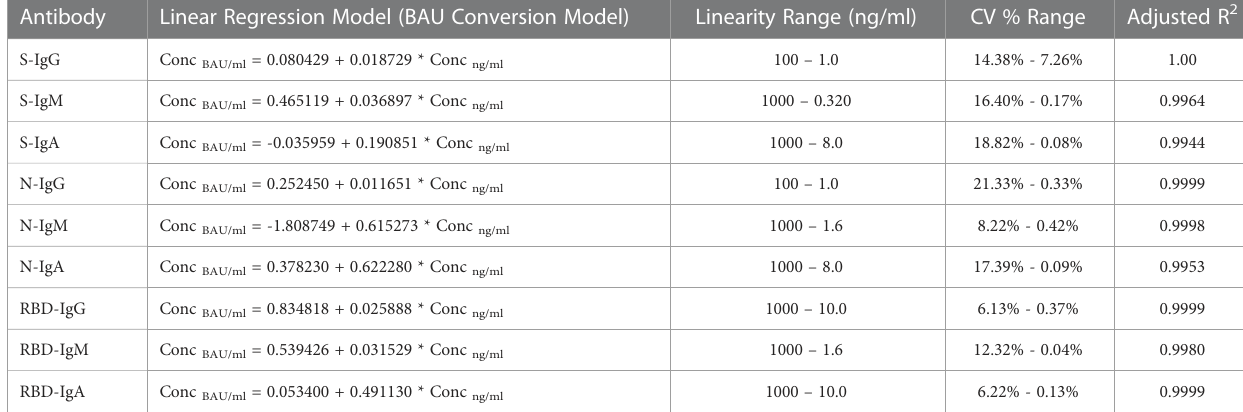
TABLE 6 Table showing the Linear Regression Conversion Models to calibrate to WHO IS units and then assay linearity range for extrapolating